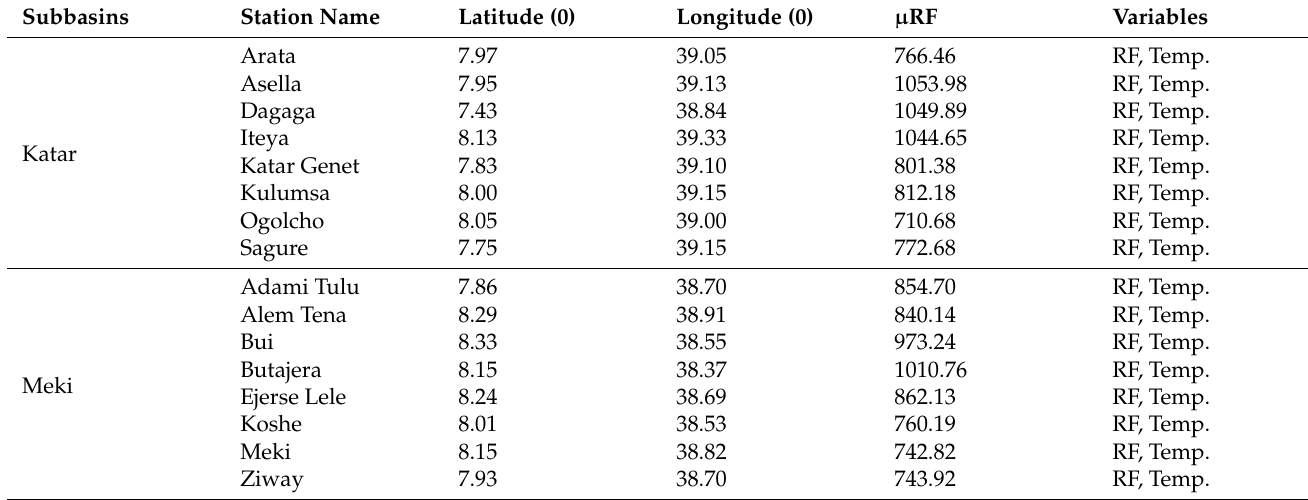
Table 1. Weather stations and summary of climate average rainfall ( µ RF)